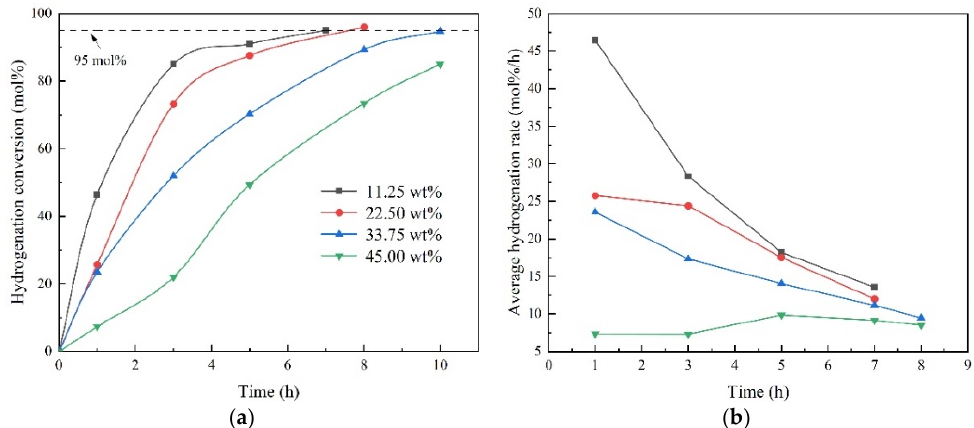
Figure 3. The XNBR conversion ( a ) and average hydrogenation ( b ) rates with different XNBR latex solid content levels. The same reaction conditions were applied as in Figure 1.